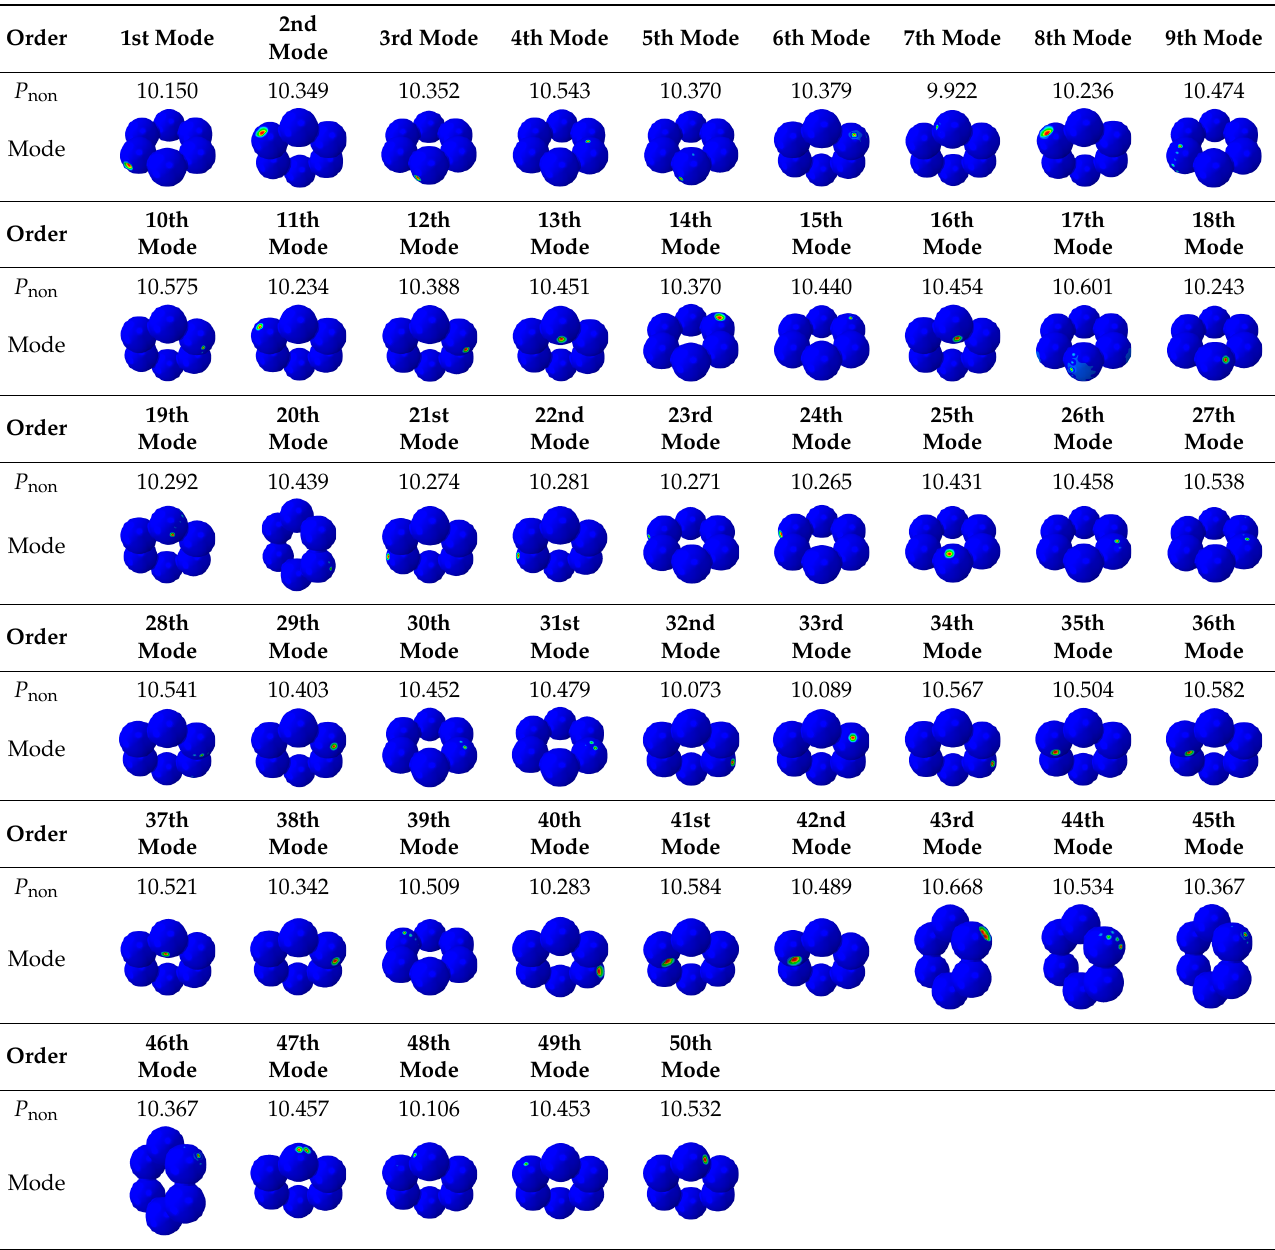
Figure 11. Normalized linear and nonlinear buckling loads for sphere-segmented toroidal shells. The post-buckling modes of the sphere-segmented toroidal shells were all localized dents. However, the local instability position presented stochastics, because it was affected by closely spaced eigenvalues. The nonlinear buckling loads are presented in the first line of Table 4, and the corresponding post-buckling modes of toroidal shells are presented in the second line of Table 4. The seventh mode was the worst, and the corresponding buckling load was a maximum value of 9.922 MPa. The 43rd mode was the best, and the corresponding buckling load was a minimum value of 10.668 MPa. Table 4. Post-buckling modes and nonlinear buckling loads of sphere-segmented toroidal shells (the results correspond to the data in Table 2).